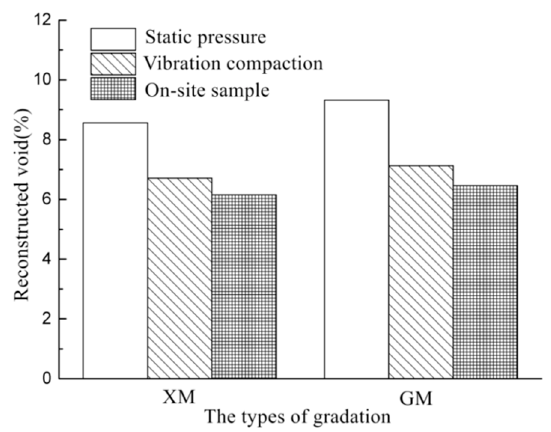
Figure 3. Extract the void information of reconstructed specimens. Table 10. The reconstructed void (%) of different molding mixtures.